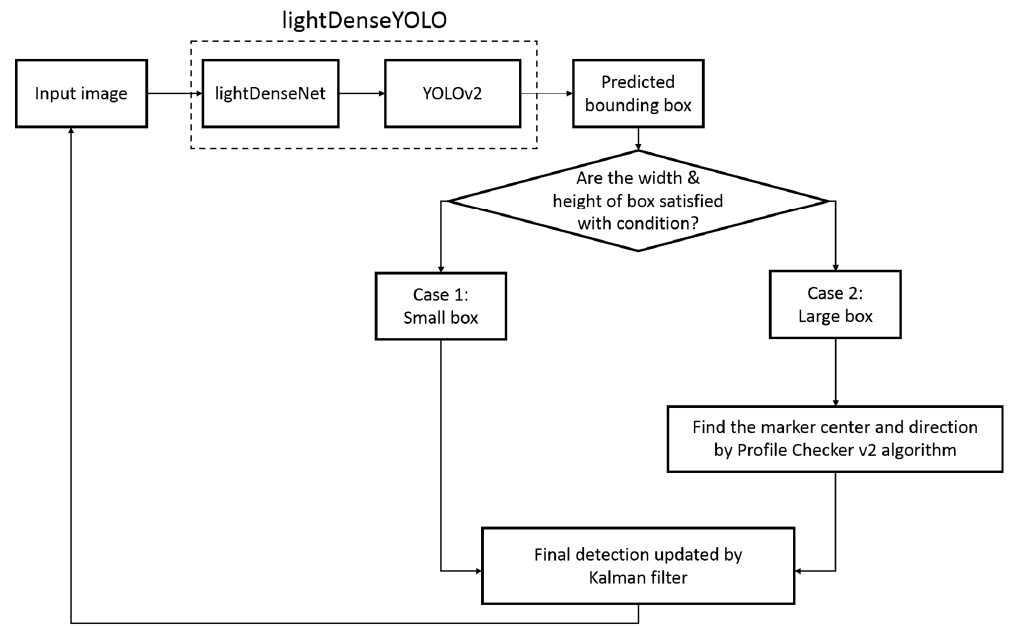
Figure 1. Flowchart of proposed far distance marker-based tracking algorithm.